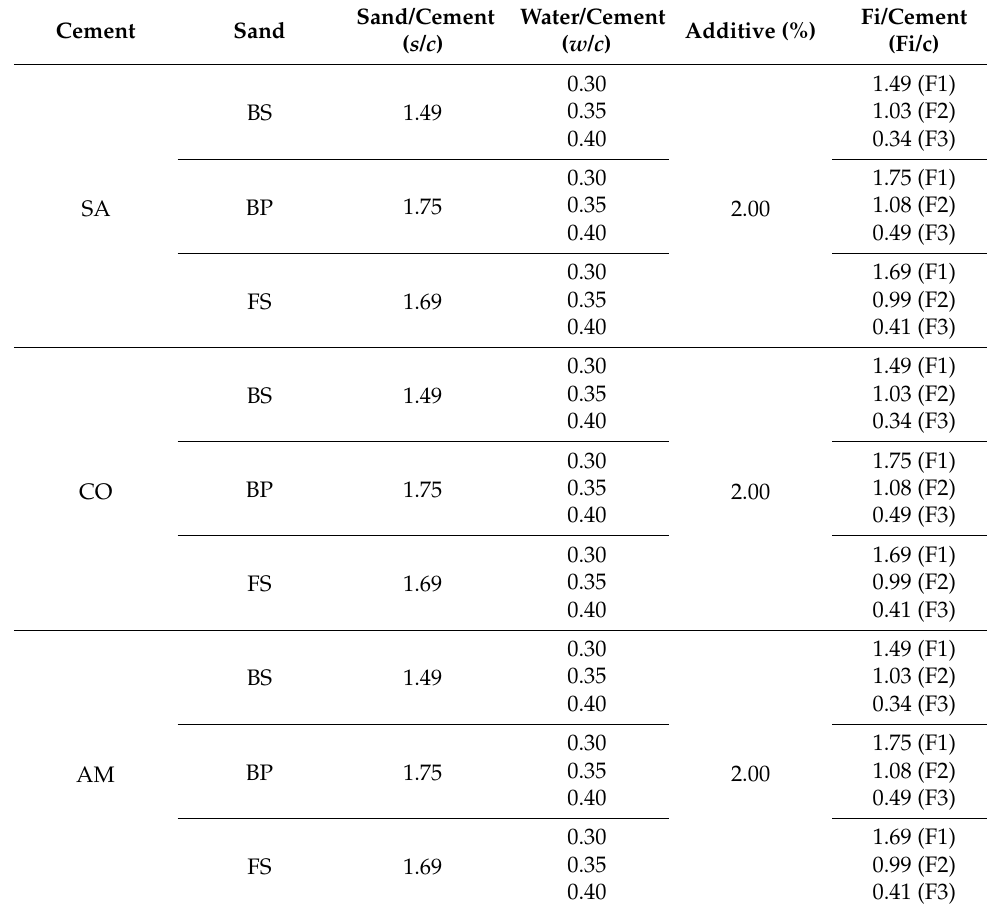
Table 6. Composition of the different